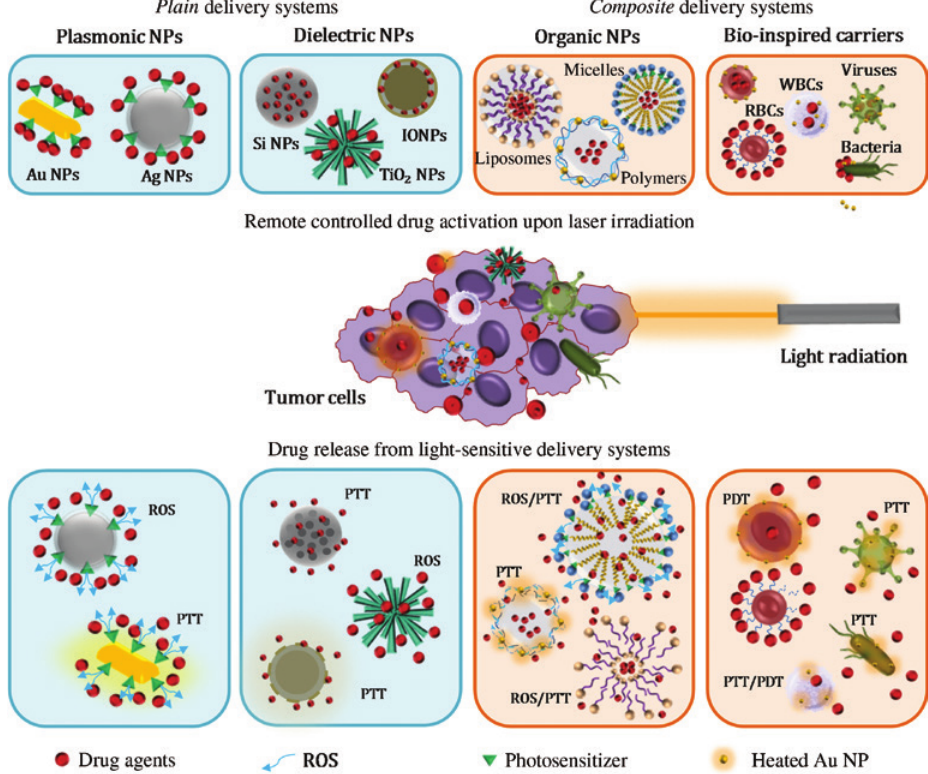
Figure 1: Schematic overview of light-sensitive delivery systems, as well as drug release